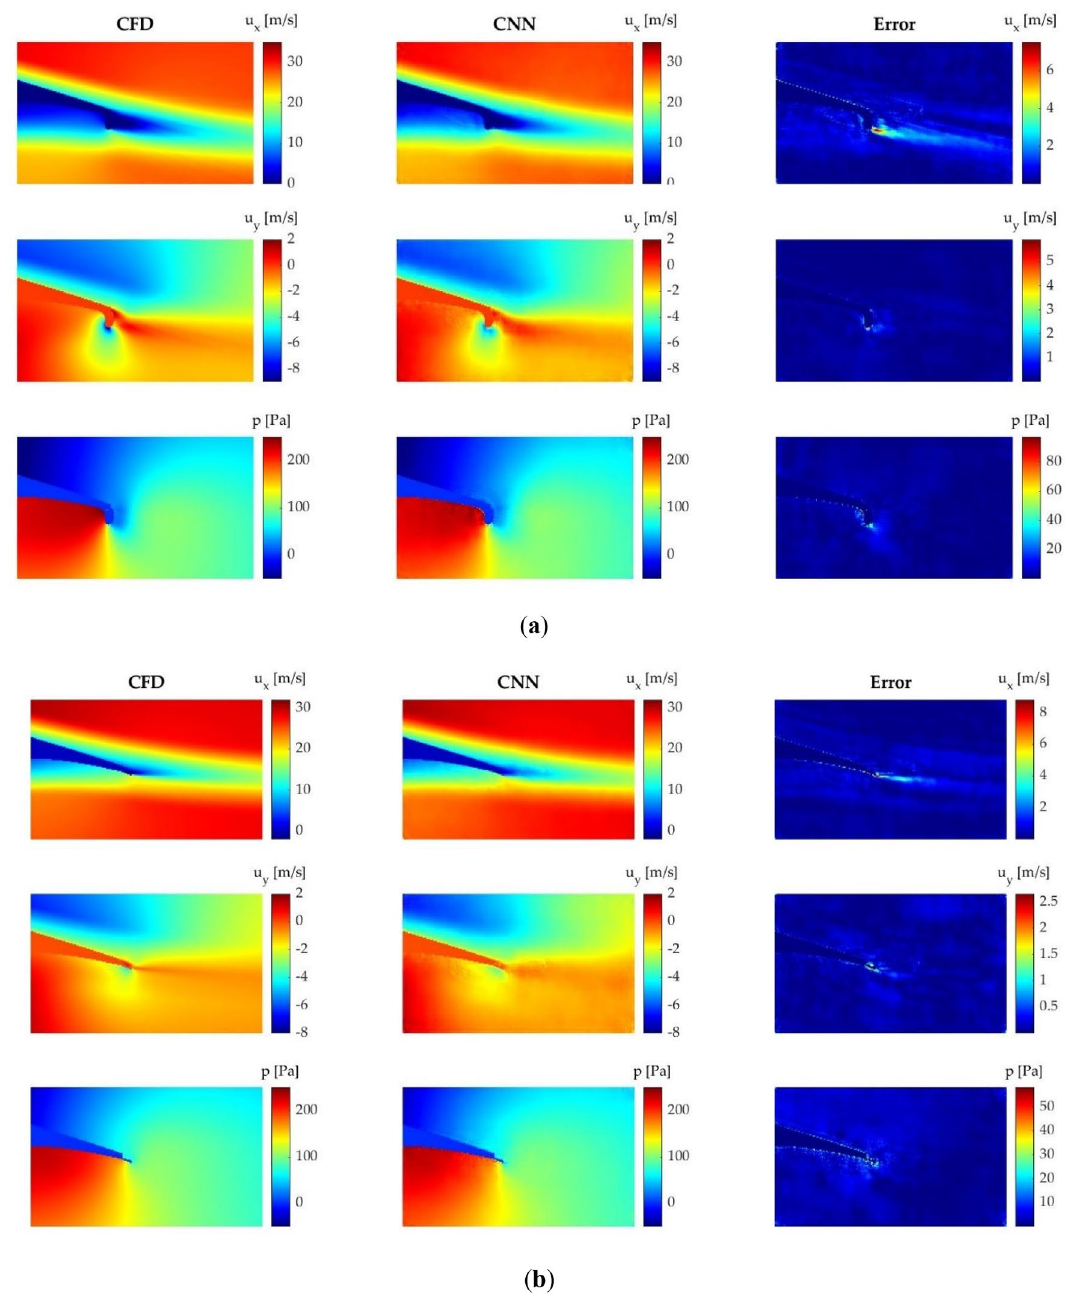
Figure 8. Comparison of the velocity and pressure fields obtained by means of CFD and CNN: ( a ) Gurney flap L = 1% and AoA = 0°; ( b ) microtab L = 1%, β = − 15° and AoA = 2°; ( c ) microtab L = 1.5%, β = − 45° and AoA =